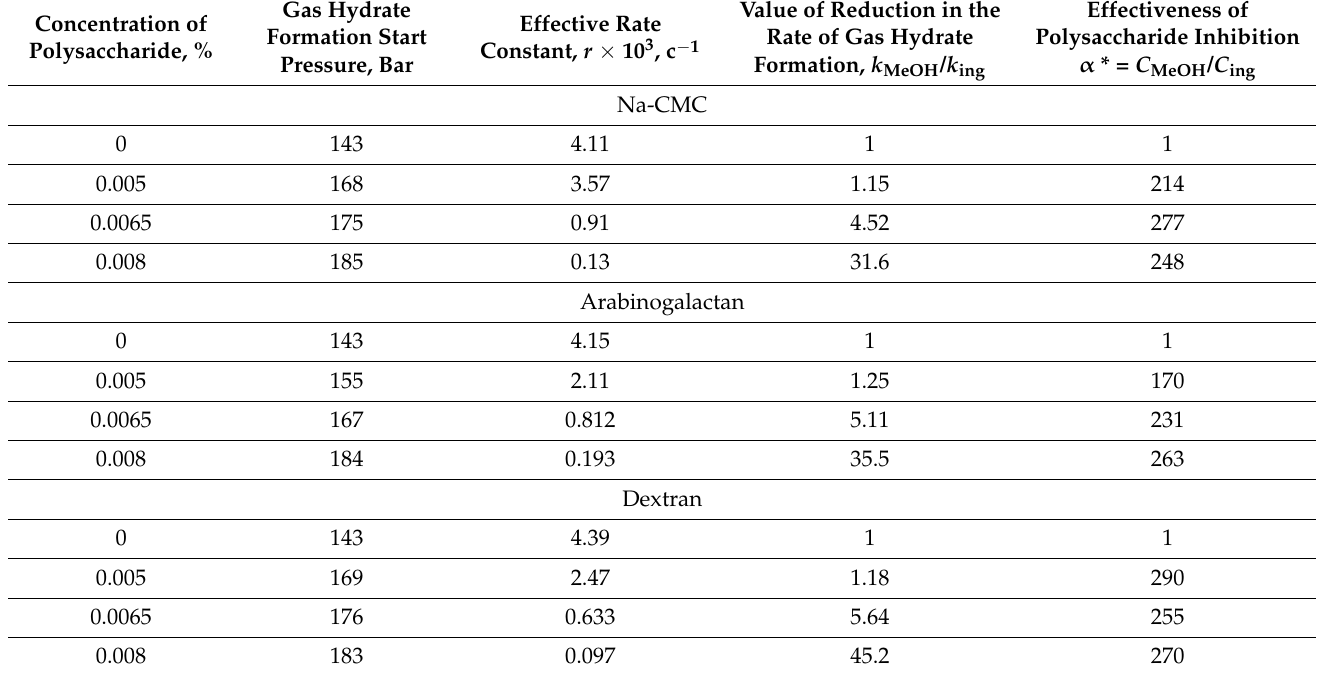
Table 2. Effective rate and pressure constants for the beginning of gas hydrate formation in the presence of Na-CMC, arabinogalactan, and dextran.